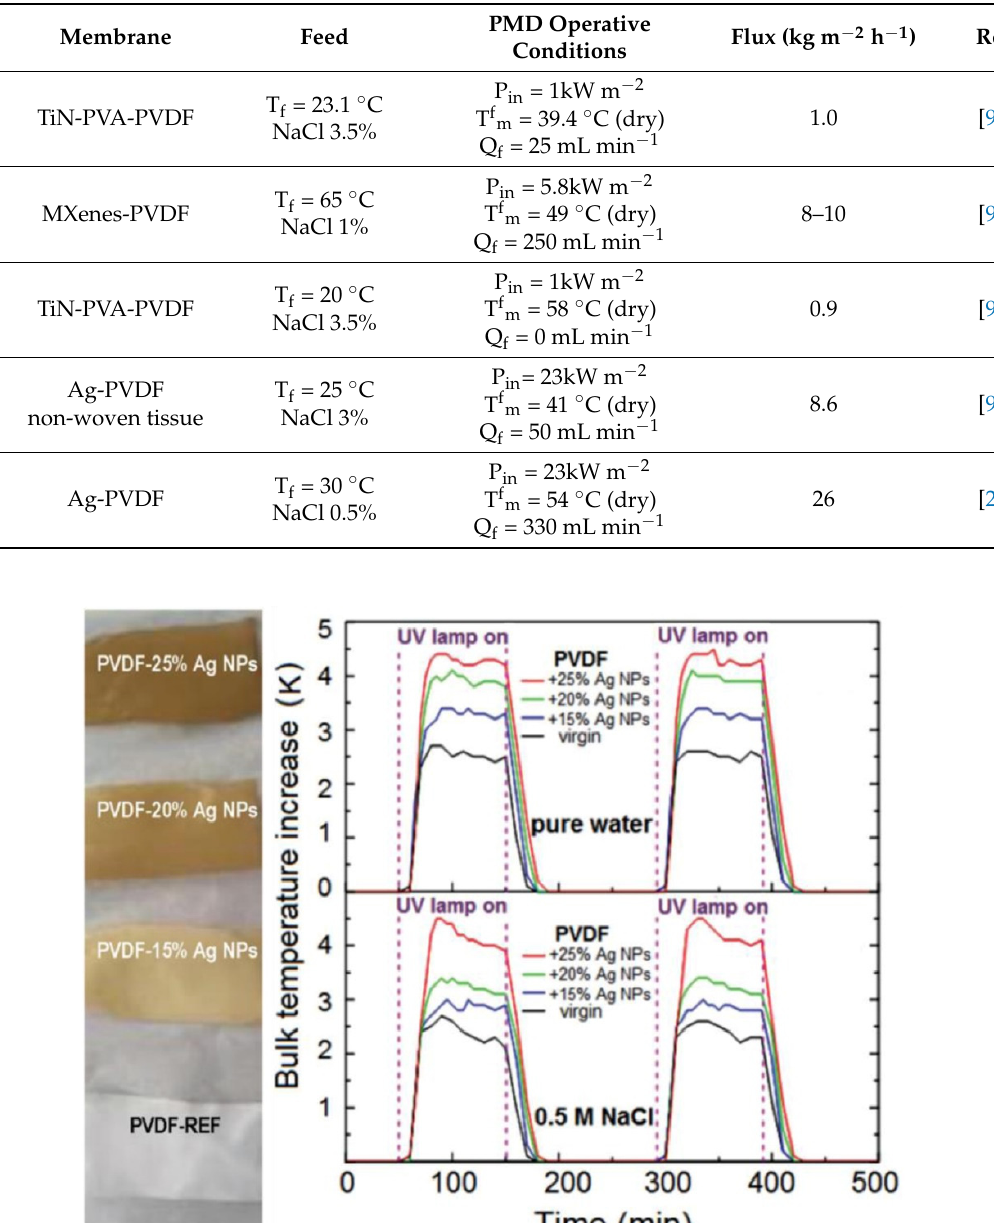
Table 4. Examples of plasmonic membranes from the literature. Modified from [43]. Reproduced with permission from Ref. [43]. Copyright 2022 Royal Society of Chemistry.